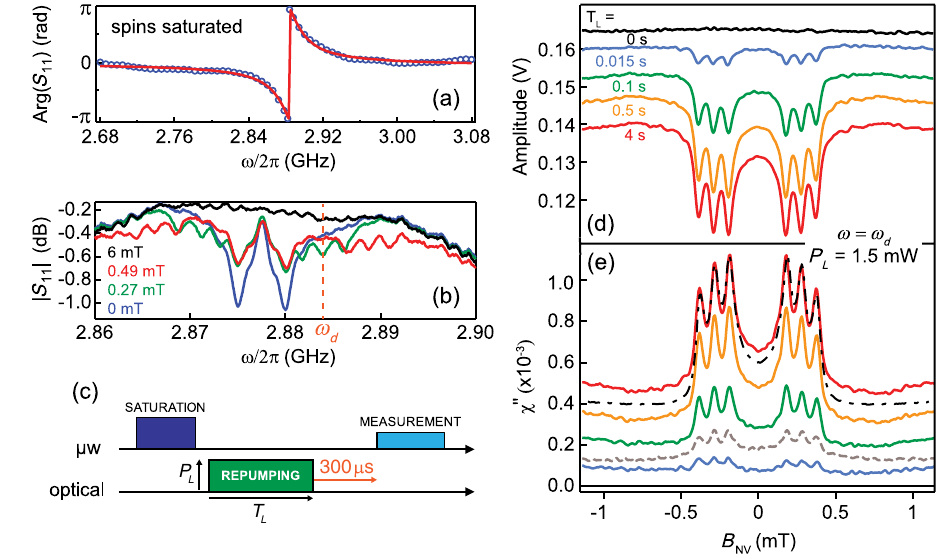
FIG. 2. Spectroscopic signals and optical repumping. (a) Measured (open circles) and fitted (solid line) phase of the reflection coefficient S 11 showing the resonator resonance at ω 0 = 2 π ¼ 2 . 88 GHz with quality factor Q ¼ 80 , when the spins are saturated and do not contribute to the signal. (b) Measured reflection coefficient modulus j S 11 j around the center of the resonator line, showing the absorption by the spins for different magnetic fields. Top line (6 mT, black) corresponds to all spins (Orth. and N-Orth.) being far detuned and shows no absorption. Other lines show several absorption peaks moving with magnetic field (subensemble N-Orth.) or not (subensemble Orth). (c) Optical reset of the NV center spins. The spins are first saturated by a 20 - μ s-long microwave pulse with frequency ω − 24 dBm; they are then optically repumped to their ground state with a laser pulse of power P T d and applied power L and duration L . After letting the system cool down during 300 μ s, the reflected amplitude of an applied weak ( − 132 dBm) 20-ms-long measurement pulse at ω d = 2 π ¼ 2 . 884 GHz is measured. (d) Reflected amplitude for P L ¼ 1 . 5 mW and different T L . The curves show the hyperfine split m S ¼ 0 to m S ¼ (cid:3) 1 spectroscopic transitions of the N-Orth. subensemble, with an amplitude that increases with T L because of Þ of the spin susceptibility. In addition, the dashed and dash- increasing spin repolarization. (e) Corresponding imaginary part χ 00 ð B NV Þ measured at thermal equilibrium (30 mK, no saturating nor optical pulse) and calculated (see the dotted lines show, respectively, χ 00 ð B NV Supplemental Material for methods and Figs. S3 and S4 [28]) and rescaled by a global factor to match the experiment at T L ¼ 4 s.